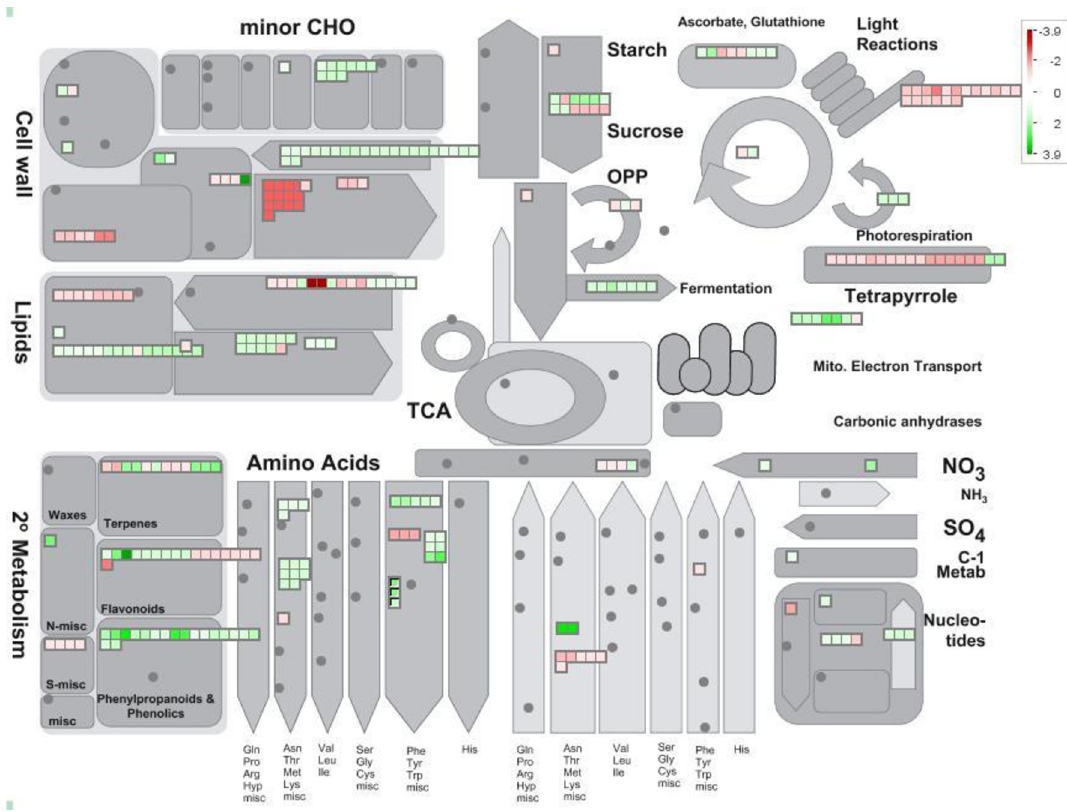
Fig 4. Metabolism overview in teosinte line Ames 21789 visualized by Mapman. Squares in red (down-regulated) or green (up- regulated) indicate individual DEGs categorized as shown.